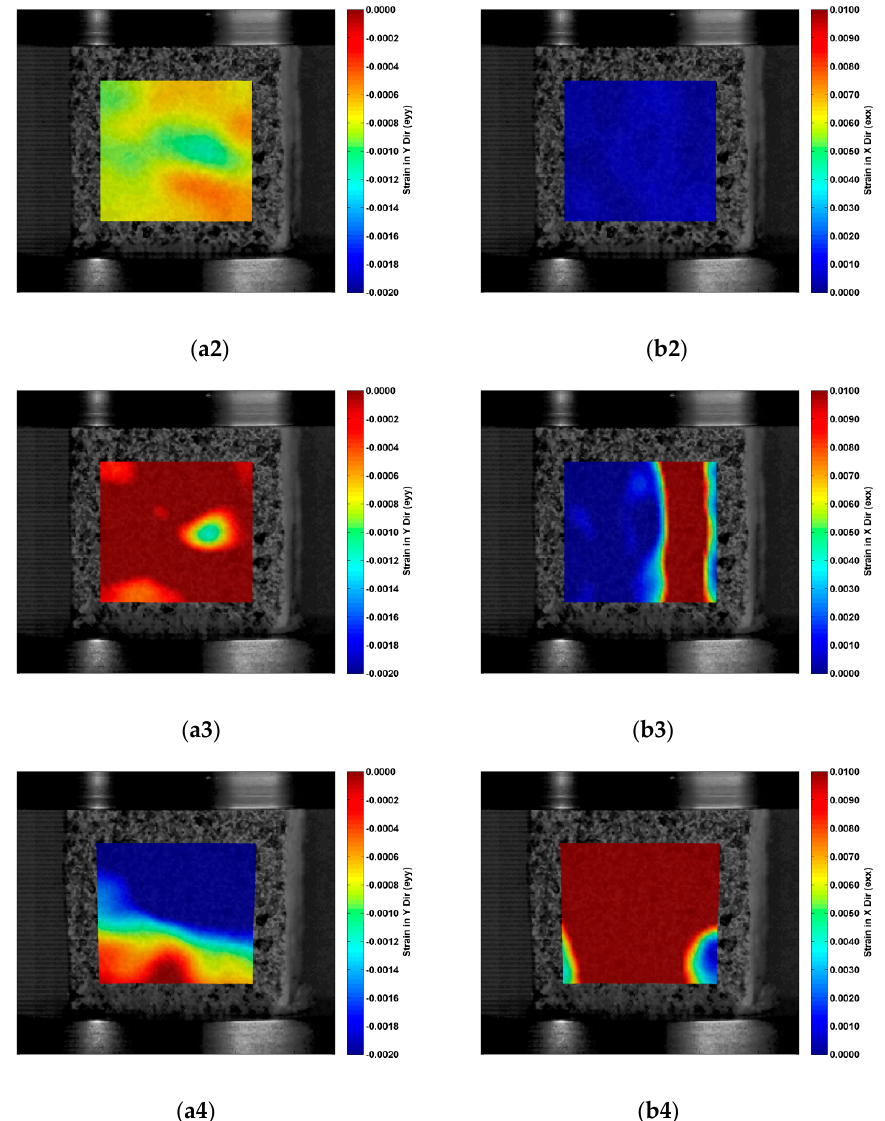
Figure 12. Results of DSCM of sample HH05mps2: ( a1 – a4 ) Strain in the y -direction; and ( b1 – b4 ) strain in the x -direction by the digital speckle correlation method (from top to bottom, figures correspond to time point 0, 0.38, 0.85 and 1.26 ms, respectively).